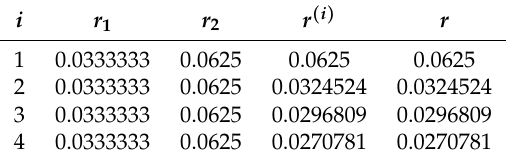
Table 3. Distinct radii of convergence.